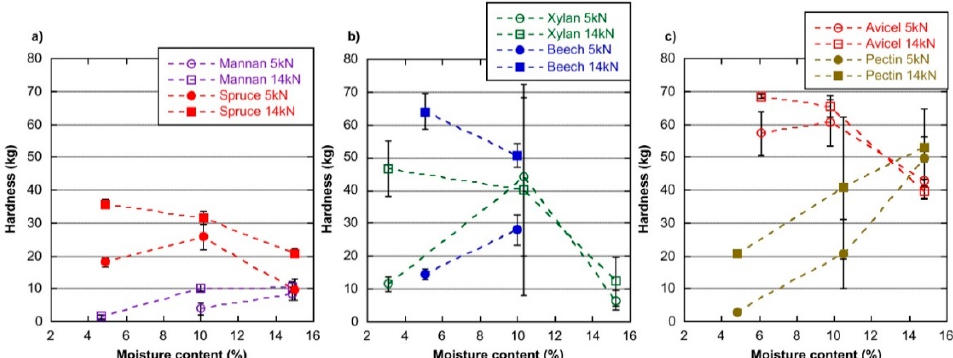
Figure 7. Pellet hardness for all of the pellets at different moisture content levels, tested after 1 month storage; ( a ) Locust bean gum mannan pellets and spruce pellets, ( b ) Eucalypt xylan pellets and beech pellets and ( c ) Avicel pellets and Apple pectin pellets.